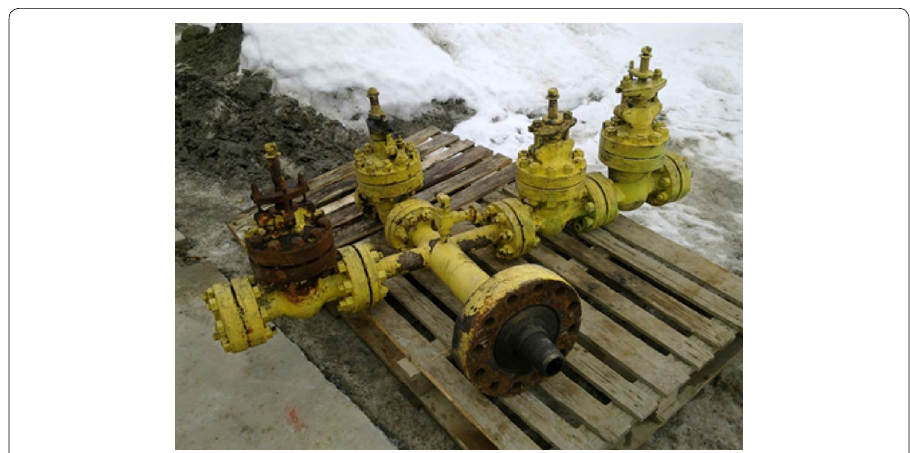
Fig. 11 Dismantled old wellhead of the Poręba Wielka IG-1 well (photo: B.